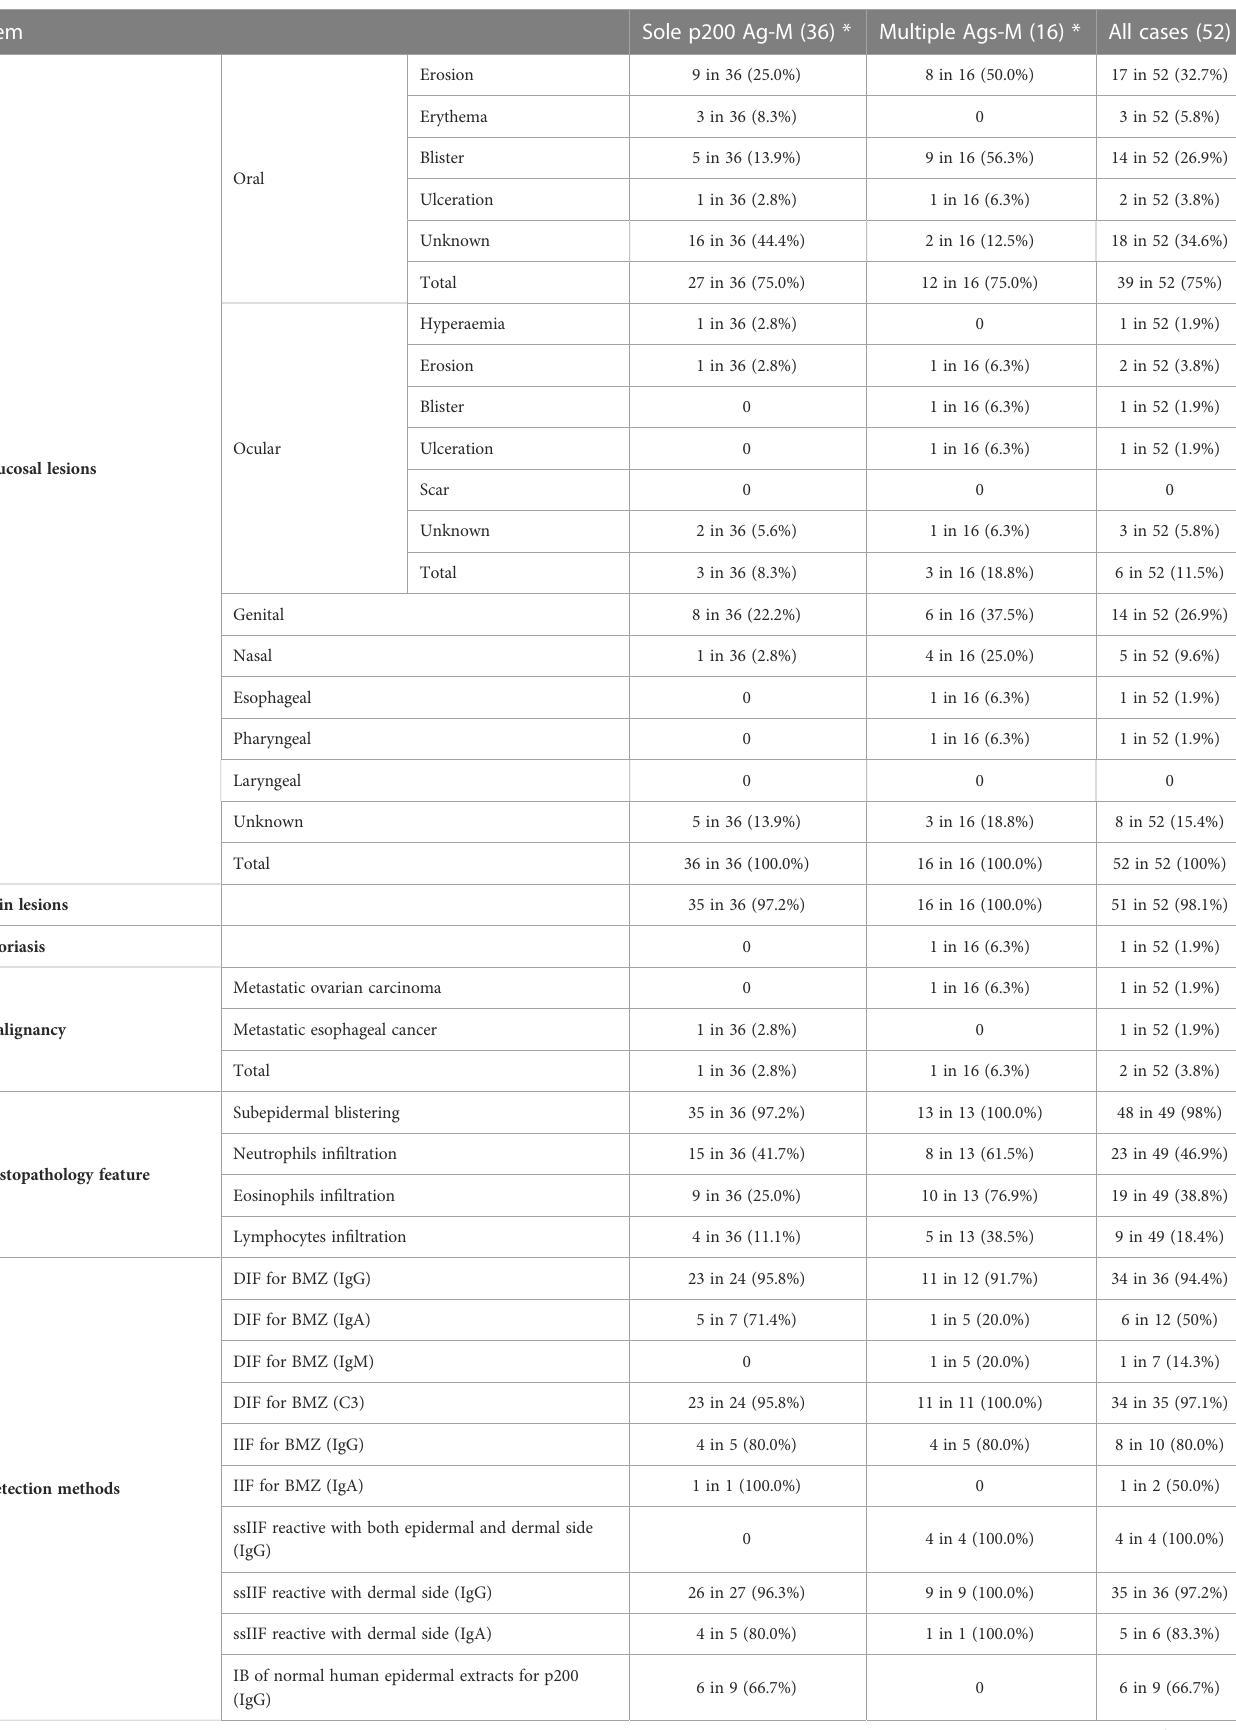
TABLE 2 Clinical, histopathological and immunological features of the 52 cases of anti-p200 pemphigoid with mucosal lesions.